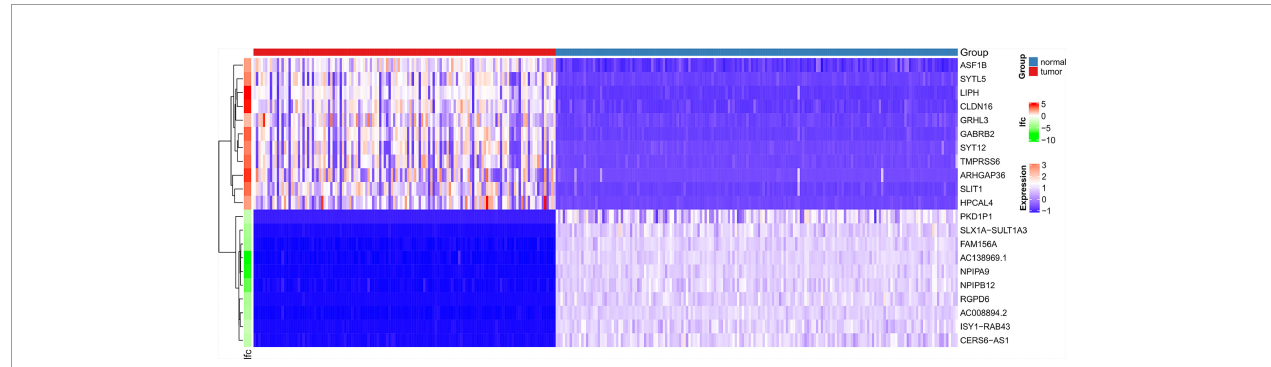
FIGURE 3 | Heatmaps of differentially expressed genes. The top 20 dysregulated (10 upregulated and 10 downregulated) DEGs and ASF1B are shown in a heatmap.